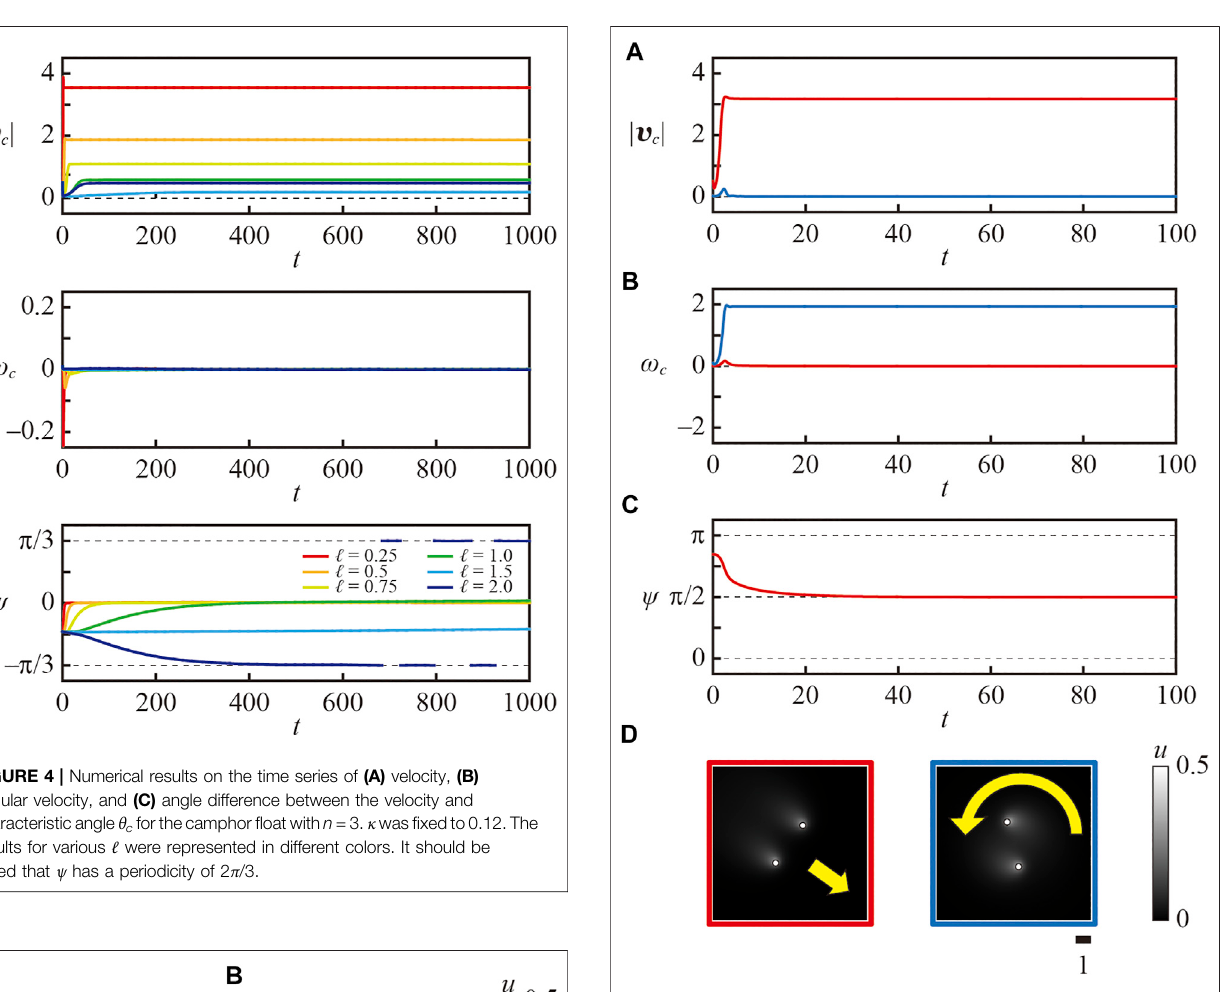
FIGURE 6 | Numerical results on the time series of (A) velocity | v c | , (B) angular velocity ω c , and (C) angle difference between the velocity and characteristicangle θ c forthecamphor fl oatwith n =2. κ was fi xedto0.08and ℓ was fi xed to 1.5. The results from various initial conditions were represented in different colors. Angle difference was plotted only for the case that | v c | was converged to a non-zero value. It should be noted that ψ has a periodicityof π . (D) Snapshotsat t =100fromeachinitialconditionindicatedin thesamecolor.Theinitialconditionswere(red) v c =0.5 e x +0.01 e y , ω c =0.01, and (blue) v c = 0.02 e x + 0.01 e y , ω c =